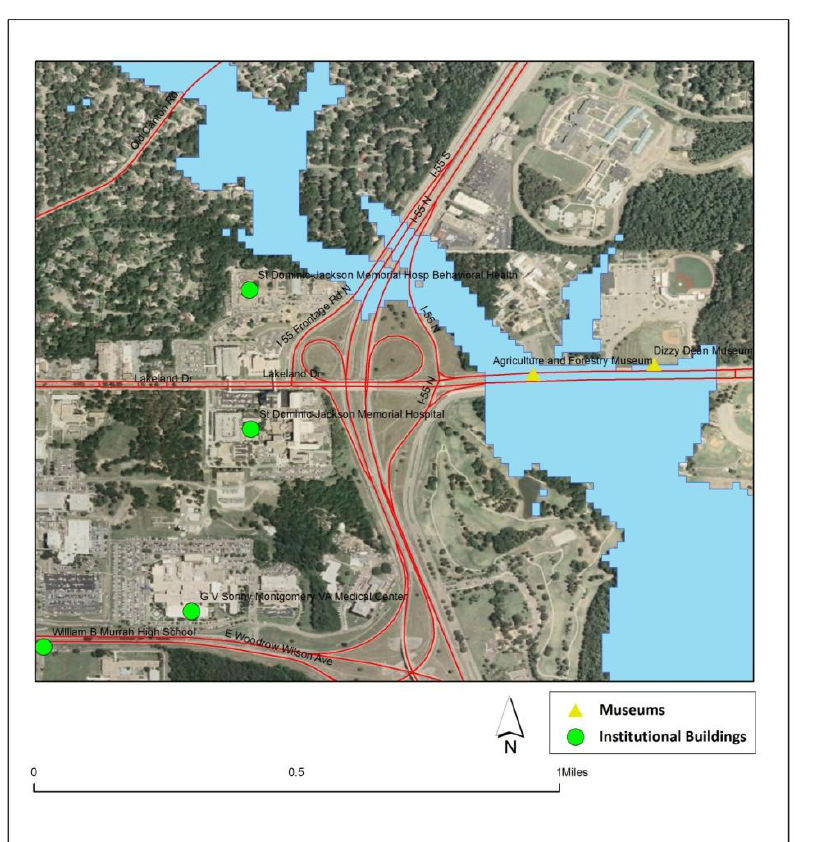
Figure 14. Ross Barnett Reservoir Flood waters at the intersection of Lake Land drive and